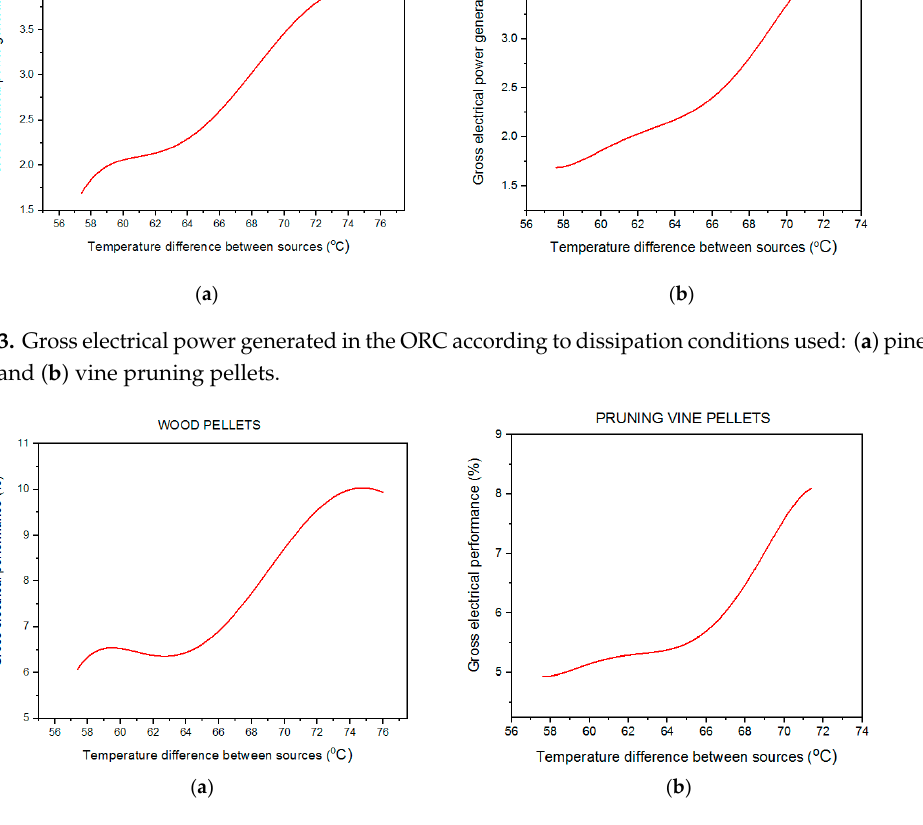
Table 6. Main characteristics of ORC at the point of maximum efficiency observed.